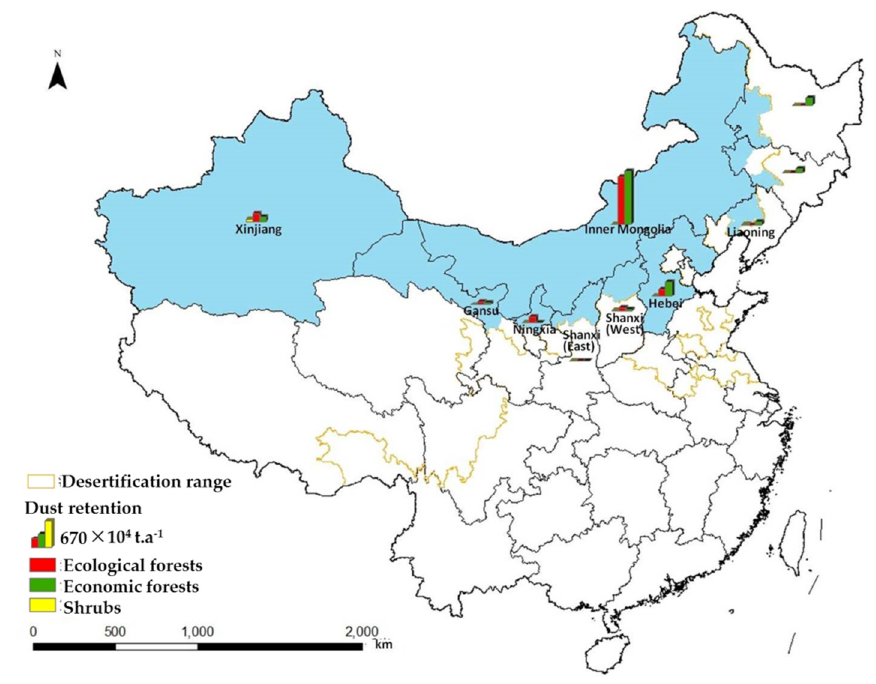
ff erent forest types.